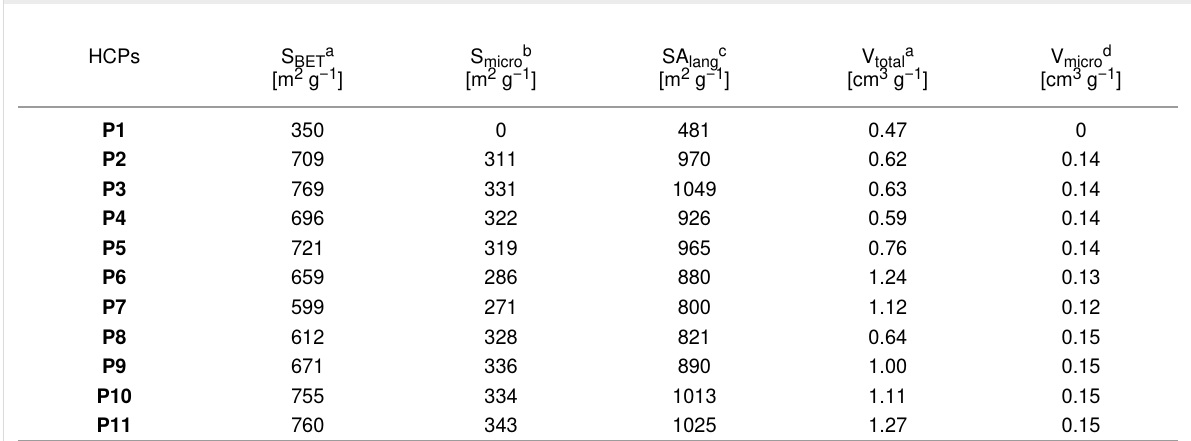
Table 2: Porosity data for HCPs.